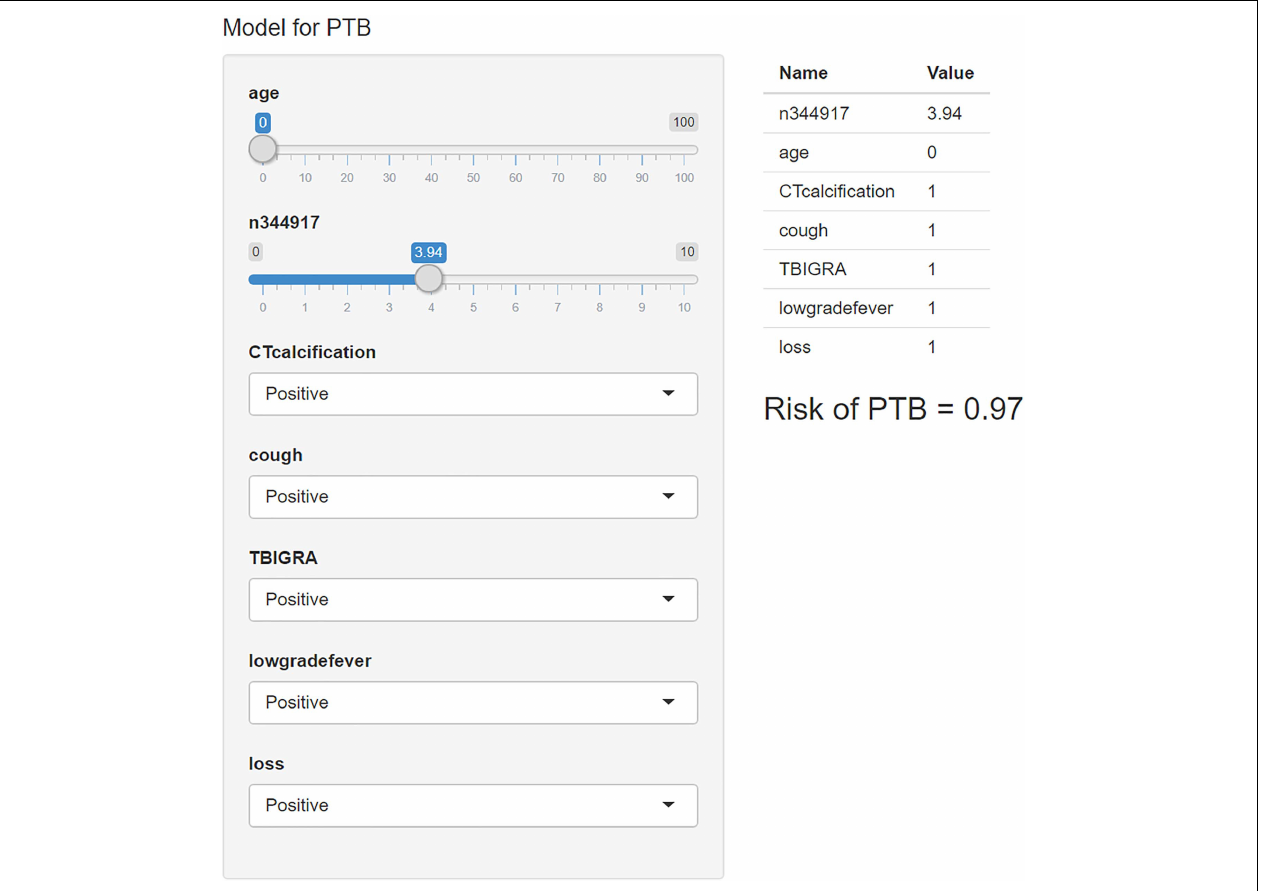
FIGURE 4 | Schematic illustration of the web application. We entered the corresponding parameters into the web application according to the laboratory information and clinical symptoms. Then, the model showed the probability of PTB.